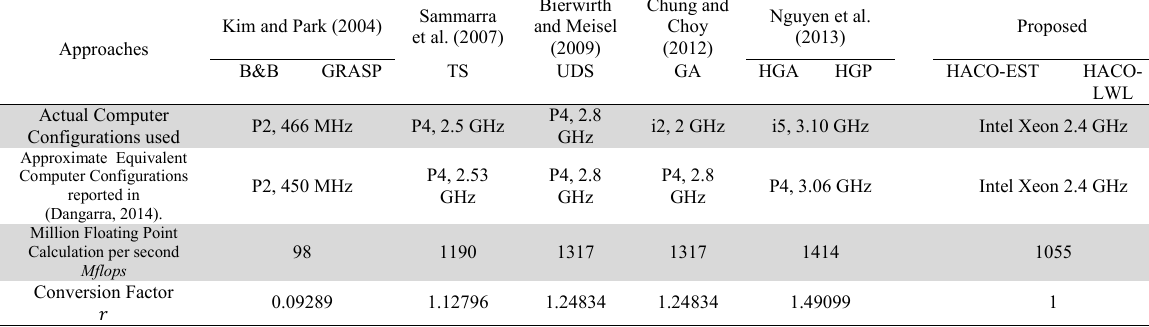
Mflops values of the different computers configurations relevant to our study.